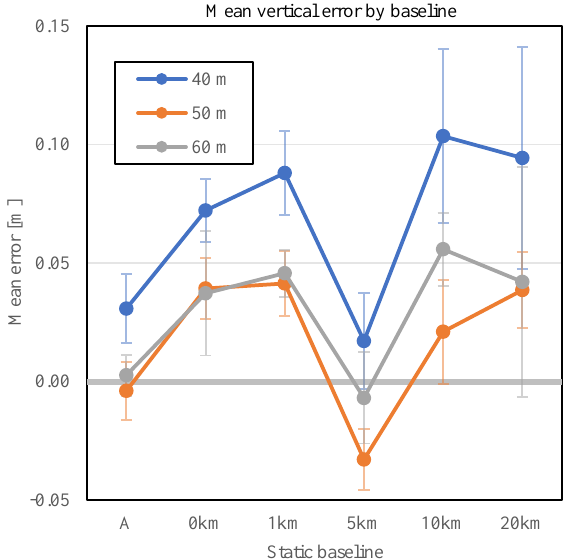
Figure 5. Mean vertical error by baseline. The error bars indicate standard